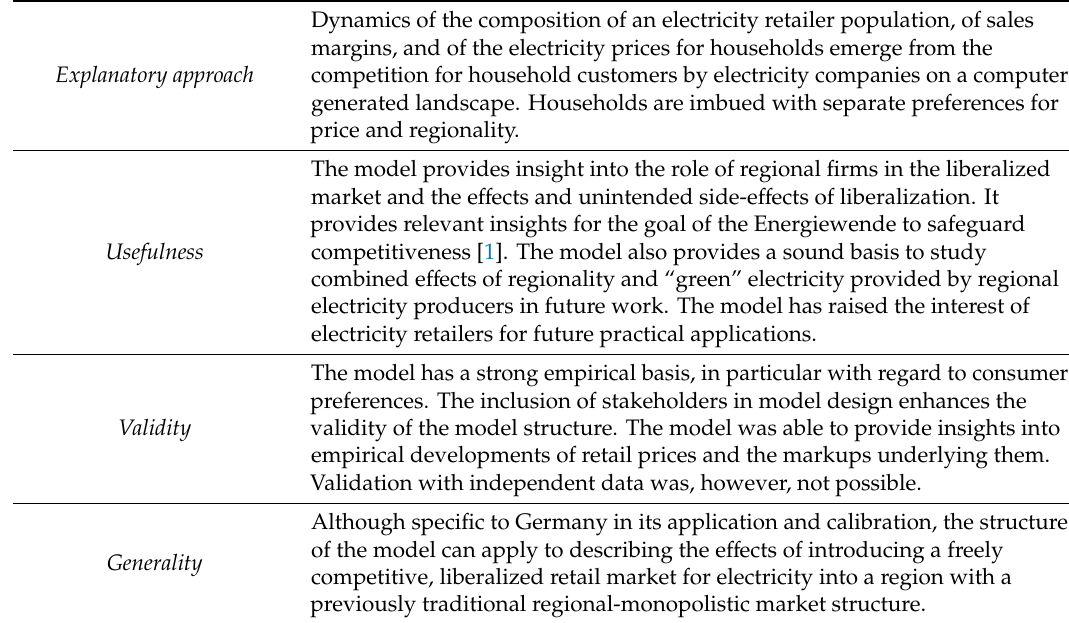
Table 2. Overall summary and assessment of case 2 (retail market) with regard to explanatory approach, usefulness, validity and generality.